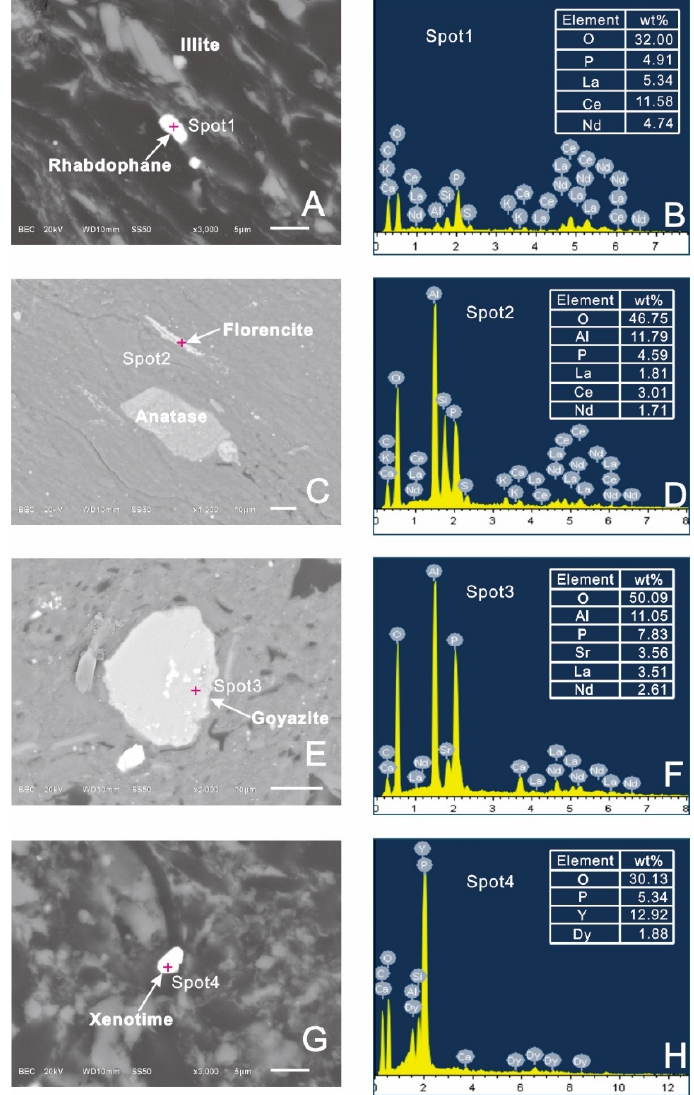
Figure 8. SEM back-scattering images of rhabdophane, florencite, goyazite, and xenotime of samples in the Donggou mine. ( A ) rhabdophane and illite in sample PSDZ-2. ( B ) the energy dispersive spectrum data of spot 1. ( C ) florencite and anatase in sample PSDZ-8. ( D ) the energy dispersive spectrum data of spot 2. ( E ) goyazite in sample PSDZ-10-f1. ( F ) the energy dispersive spectrum data of spot 3. ( G ) xenotime in sample PSDZ-5. ( H ) the energy dispersive spectrum data of spot